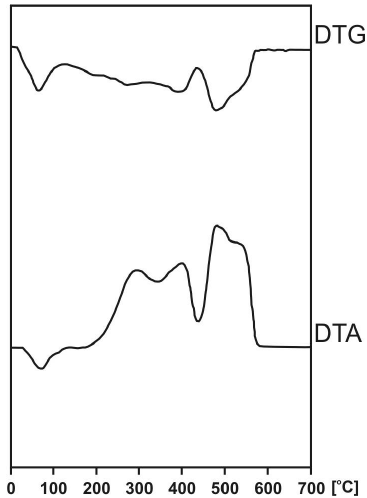
Figure 4. Thermogram of HAs isolated from Kusowo Bog at the depth 25 – 50 cm.